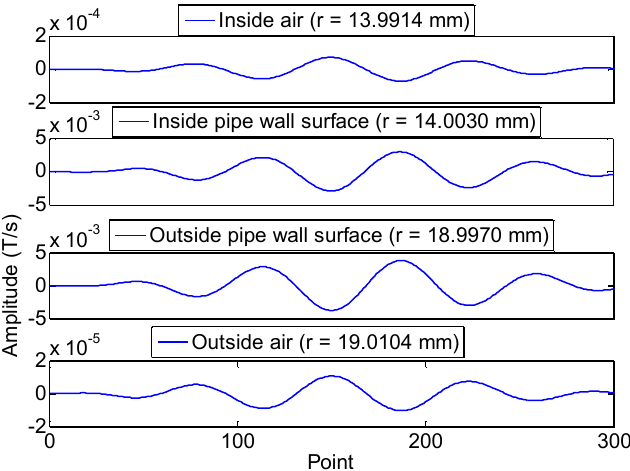
Figure 5. The FE calculation results of the changing rate of magnetic flux density of four radial points at 20 kHz.